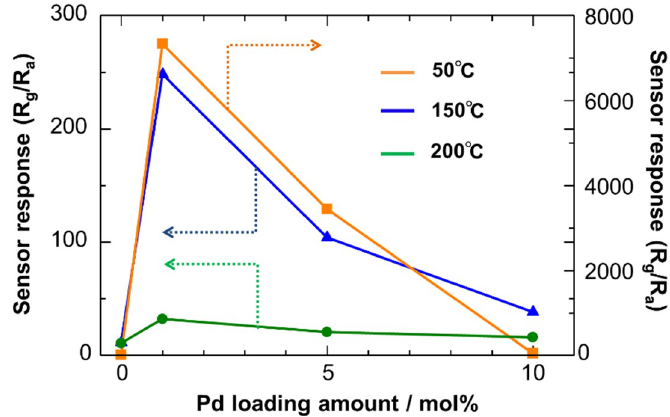
Figure 10. Dependence of sensor response to 8 ppm H 2 S in air on Pd loading amount for the Pd-loaded Cu 2 O NC sensors operated at different temperatures.